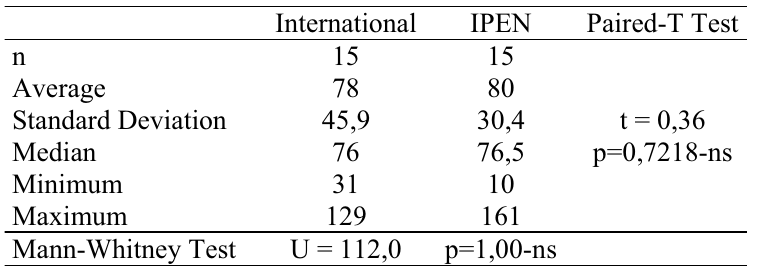
TABLE 4 – Comparison between the values of radiation reading of the ex vivo SLN using the International and the IPEN intraoperatory gamma